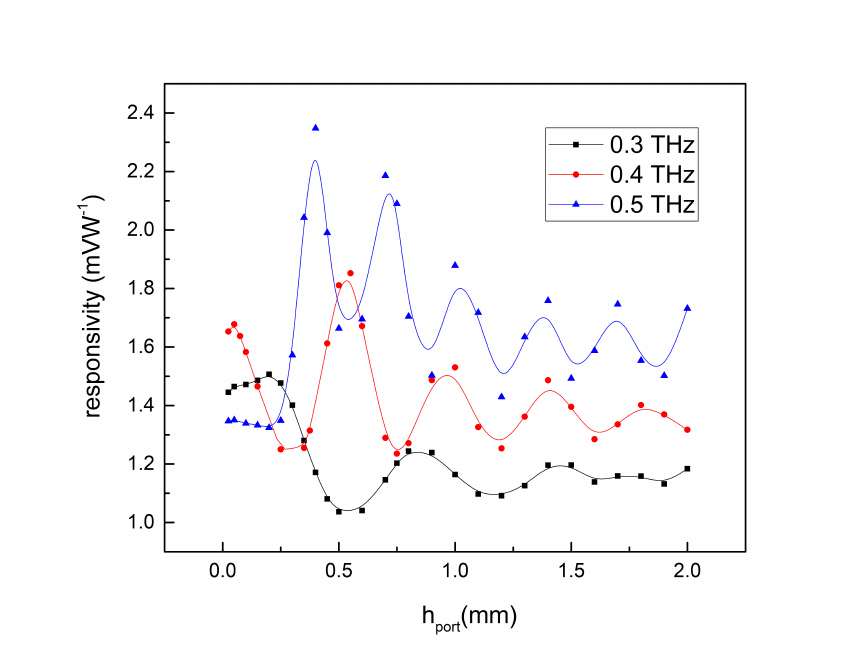
Figure 11. Responsivity of antenna on h port in frequency range from 0.3–0.5